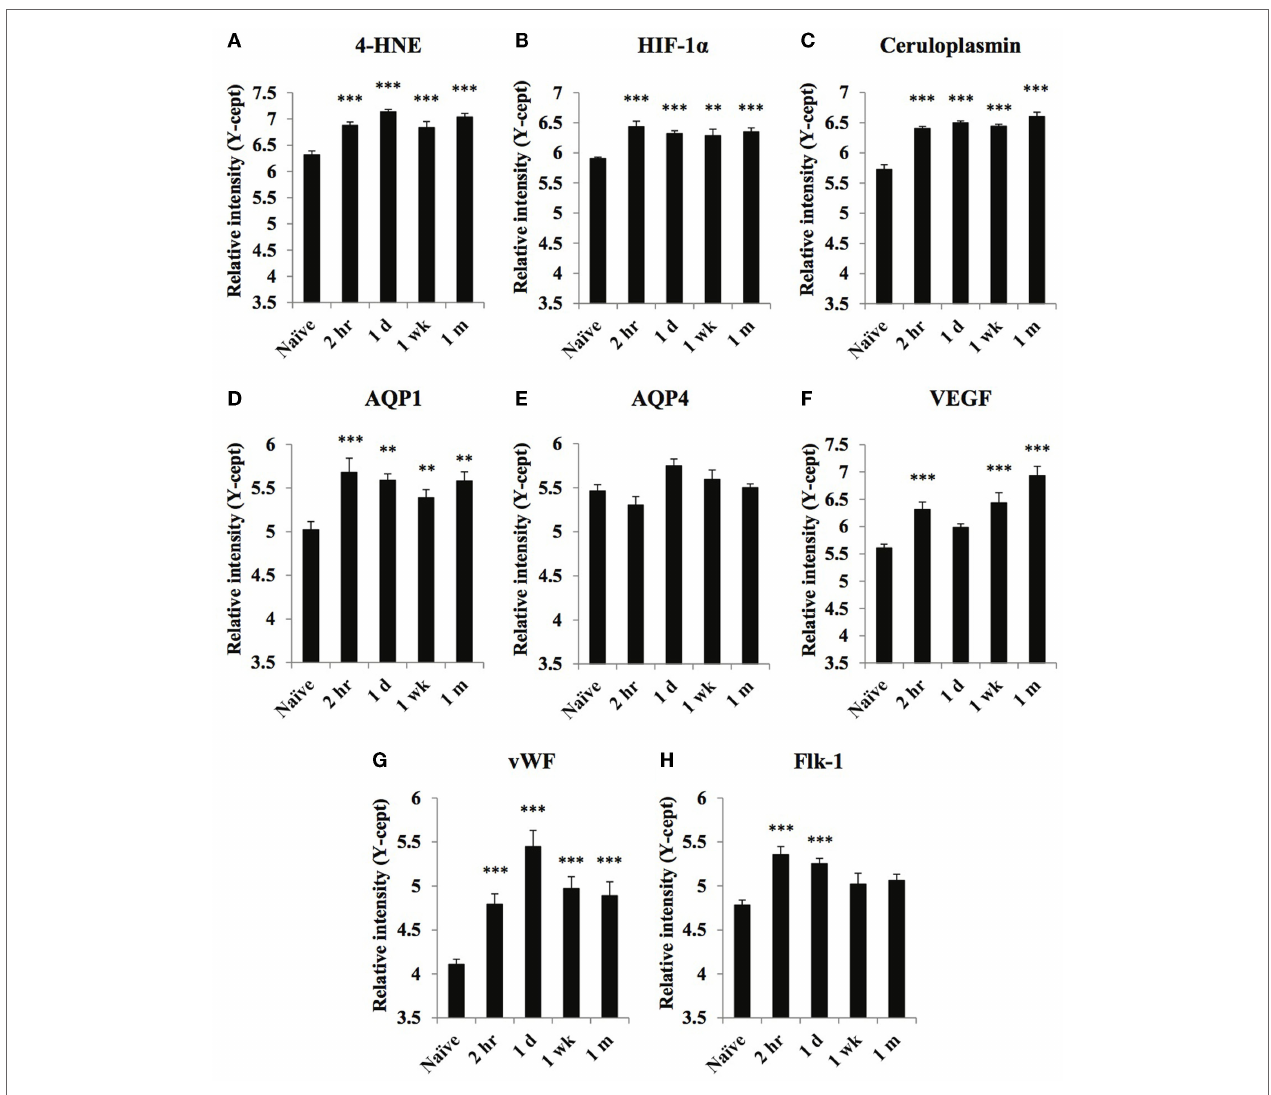
related biomarkers AQP1 (D) , AQP4 (e) , VEGF (F) , vWF (g) , and FLK-1 (h) were assayed using reverse phase protein microarray (RPPM) and are expressed as y -cept values (log 10). Data are presented as the mean ± SEM; ** p < 0.01, *** p <